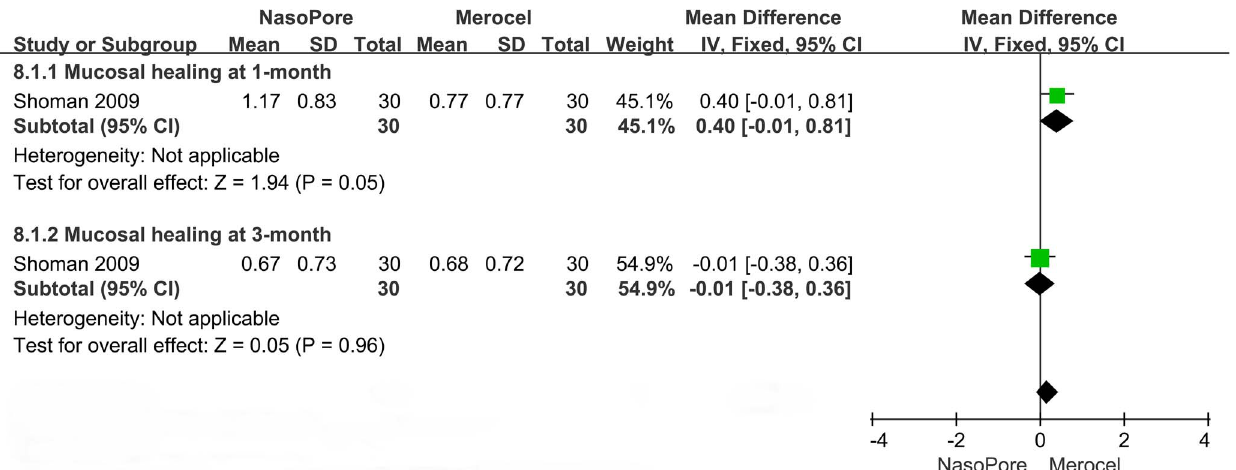
Figure 8. Forest plots of MD and 95% CI for mucosal healing at 1-month and 3-month.